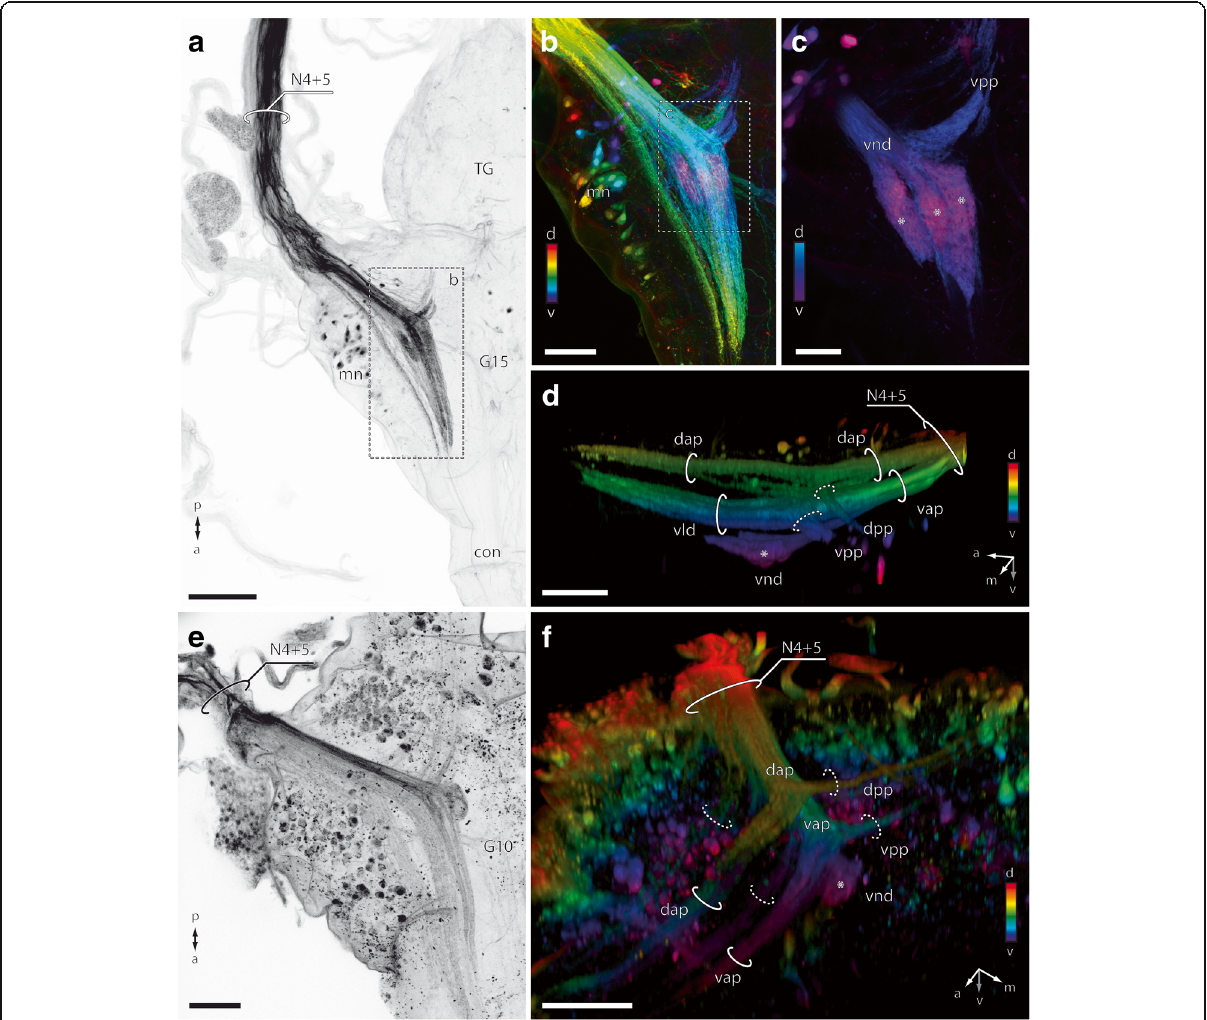
Fig. 9 Backfill experiments. a – d Backfill of the ultimate leg nerves N4 + N5. e , f Backfill of the walking leg 10 nerves N4 + N5. a Black/white inverted cLSM maximum projection of ultimate leg nerve backfill, view from dorsal, right hemiganglion. Note the intensely labeled motoneurons (mn) in the lateral cortex of G15. Scale bar 100 μ m. b Backfill of ultimate leg nerve a depth color coded. The ventralmost area (purple) is characterized by the vnd (compare c ). Scale bar 50 μ m. c Subsection of b , the ventral neuropilar domain features three distinct glomerular subunits (asterisks). Scale bar 25 μ m. d Depth color-coded 3D visualization (Amira) showing the dorso-ventral organization of N4 + N5 afferents, view from medial. N4 + N5 split into a dorsal anteriad projection (dap) and a ventral anteriad projection (vap). Both projections each branch off a small posteriad projection (dorsal and ventral posteriad projections, dpp and vpp). The vap splits into the ventral lamellate domain (vld) and the ventral neuropilar domain (vnd, asterisk). Scale bar 50 μ m. e Black/white inverted cLSM maximum projection of waking leg nerve backfill, right hemiganglion. Note the intensely labeled neurons in the lateral and ventral cortex of G10. Scale bar 50 μ m. f Depth color coded 3D visualization of backfill ( e ) showing the dorsoventral organization of N4 + N5 afferents, view from dorsomedial. The general branching pattern is similar to the ultimate leg-associated ganglion (compare d ). However, the ventral anteriad projection is not differentiated into a lamellate domain, only giving rise to the ventral neuropilar domain (vnd, asterisk) which is far smaller in comparison. Scale bar 50 μ m. Abbreviations: con connective, cu cuticle, dap dorsal anteriad projection, dpp dorsal posteriad projection, G ganglion of the vnc, mn motoneurons, N nerve, TG terminal ganglion, vap ventral anteriad projection, vld ventral lamellate domain, vnd ventral neuropilar domain, vpp ventral posteriad